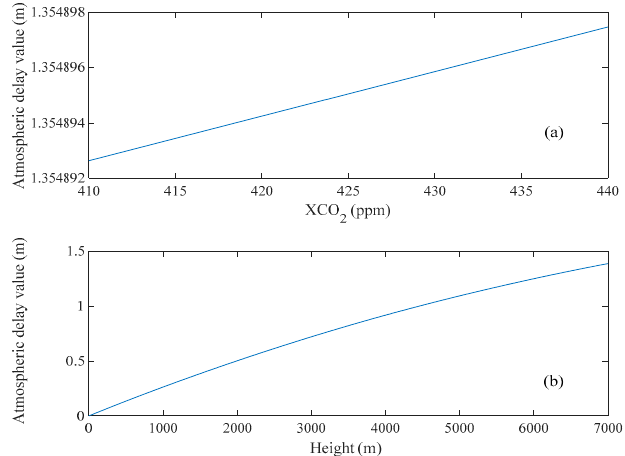
Figure 8. Results of the calculation of the atmospheric delay correction term. ( a ) shows the atmospheric delay results for di ff erent CO 2 concentrations at the altitude of 6.8 km. ( b ) shows the atmospheric delay results for di ff erent altitudes calculated with a CO 2 concentration of 420